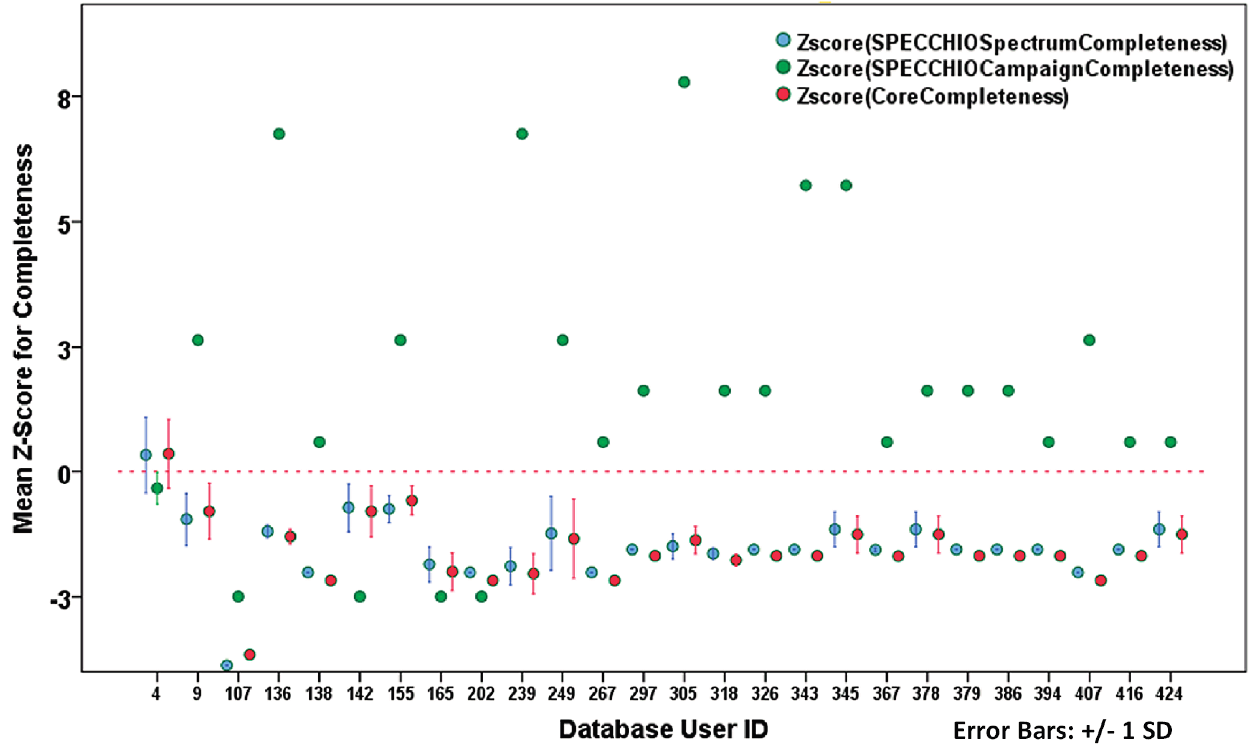
Figure 1. Mean Z-scores for completeness by database